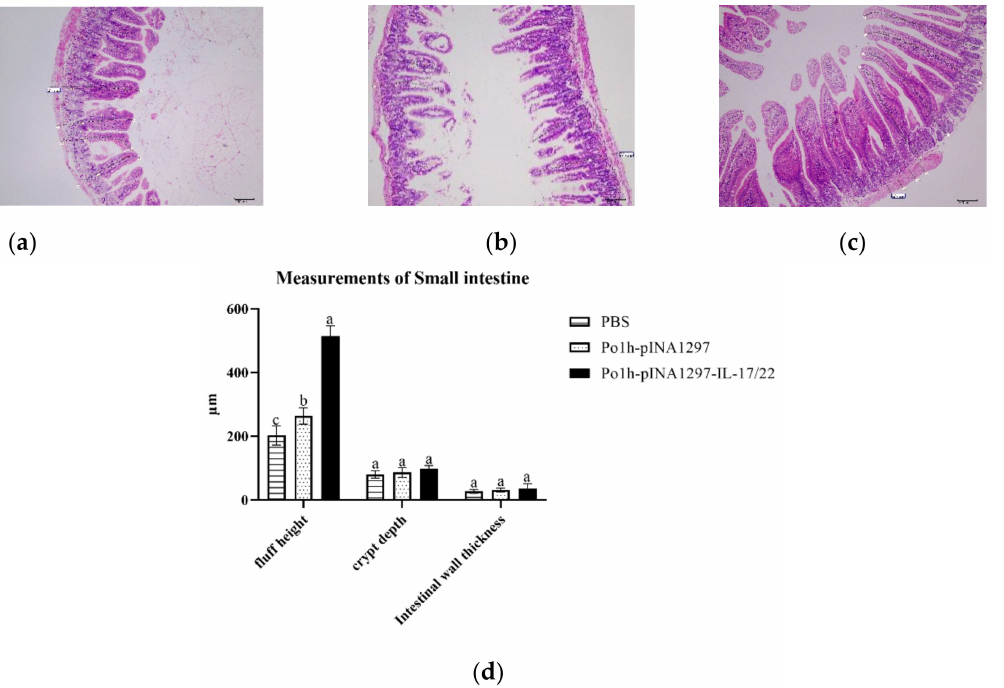
Figure 9. Hematoxylin and eosin staining of small intestine tissues. Histologic examination showed the fluff height, crypt depth, and intestinal wall thickness in PBS ( a ), Po1h-pINA1297 ( b ) and Po1h- pINA1297-IL-17/22 groups ( c ) and their statistical comparison ( d ) respectively. Scale bar = 100 µ m. The data with different letter are significantly different, p <